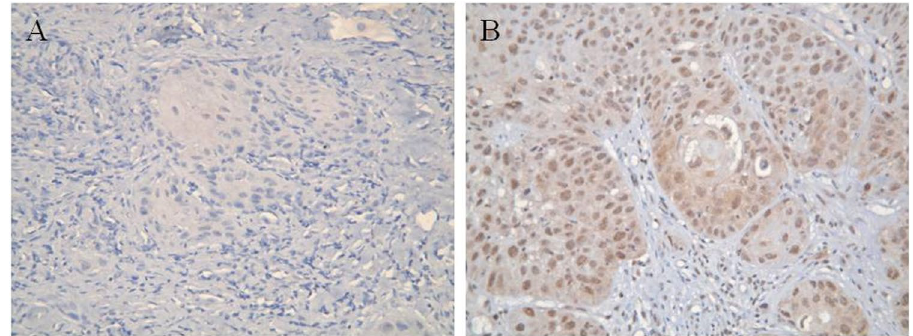
Figure 1. Immunohistochemical staining of p-mTOR. ( A ) Representative image of low p-mTOR expression. ( B ) Representative image of p-mTOR overexpression. Original magnification × 200.